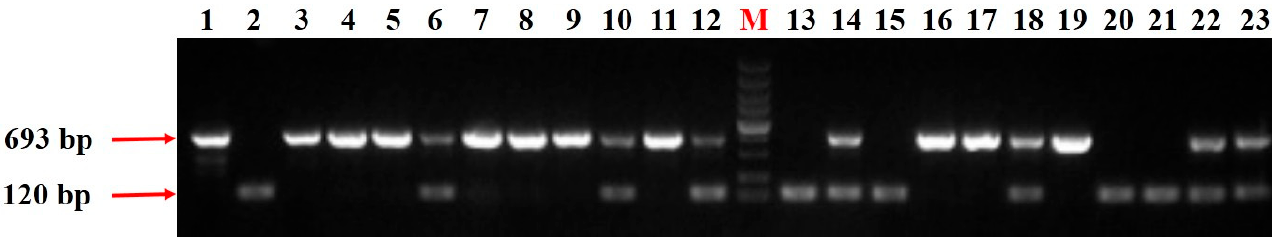
Figure 4. Partial molecular marker experimental results of the InDel marker BnA05ID1. ‘M’ denotes 5000 marker. The number 1, 3–5, 7–9, 11, 16–17, and 19 denote the PCR products from homozygous plants with up-curling leaf and downward-pointing silique. The number 6, 10, 12, 14, 18, 22, and 23 denote the PCR products from heterozygous plants with up-curling leaf and downward-pointing silique. The number 2, 13, 15, 20, and 21 denote the PCR products from homozygous plants with flatten leaf and upright silique. Table 2. Genes in the mapped interval and the Brassica within the interval on the A05 chromosome. Gene in B. napus. cv Gene in B. napus. cv ZS11 Darmor